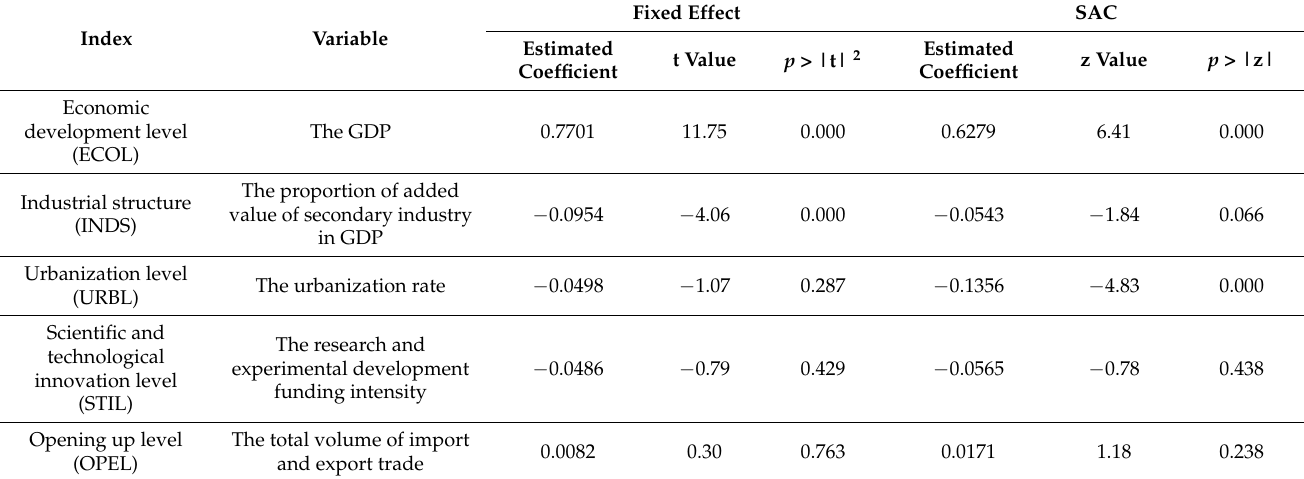
Table 4. Table of the empirical estimation